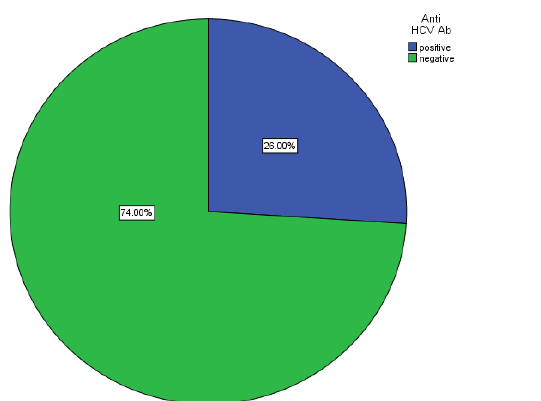
Figure 1: The prevalence rate of Hepatitis among the study group.